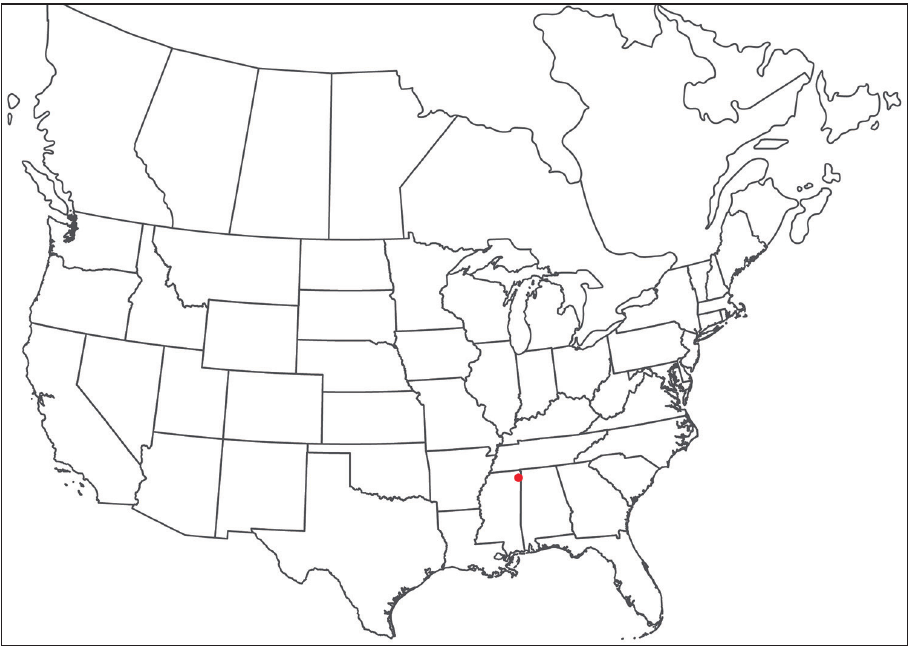
Figure 67. Torrenticola elongata sp. n.